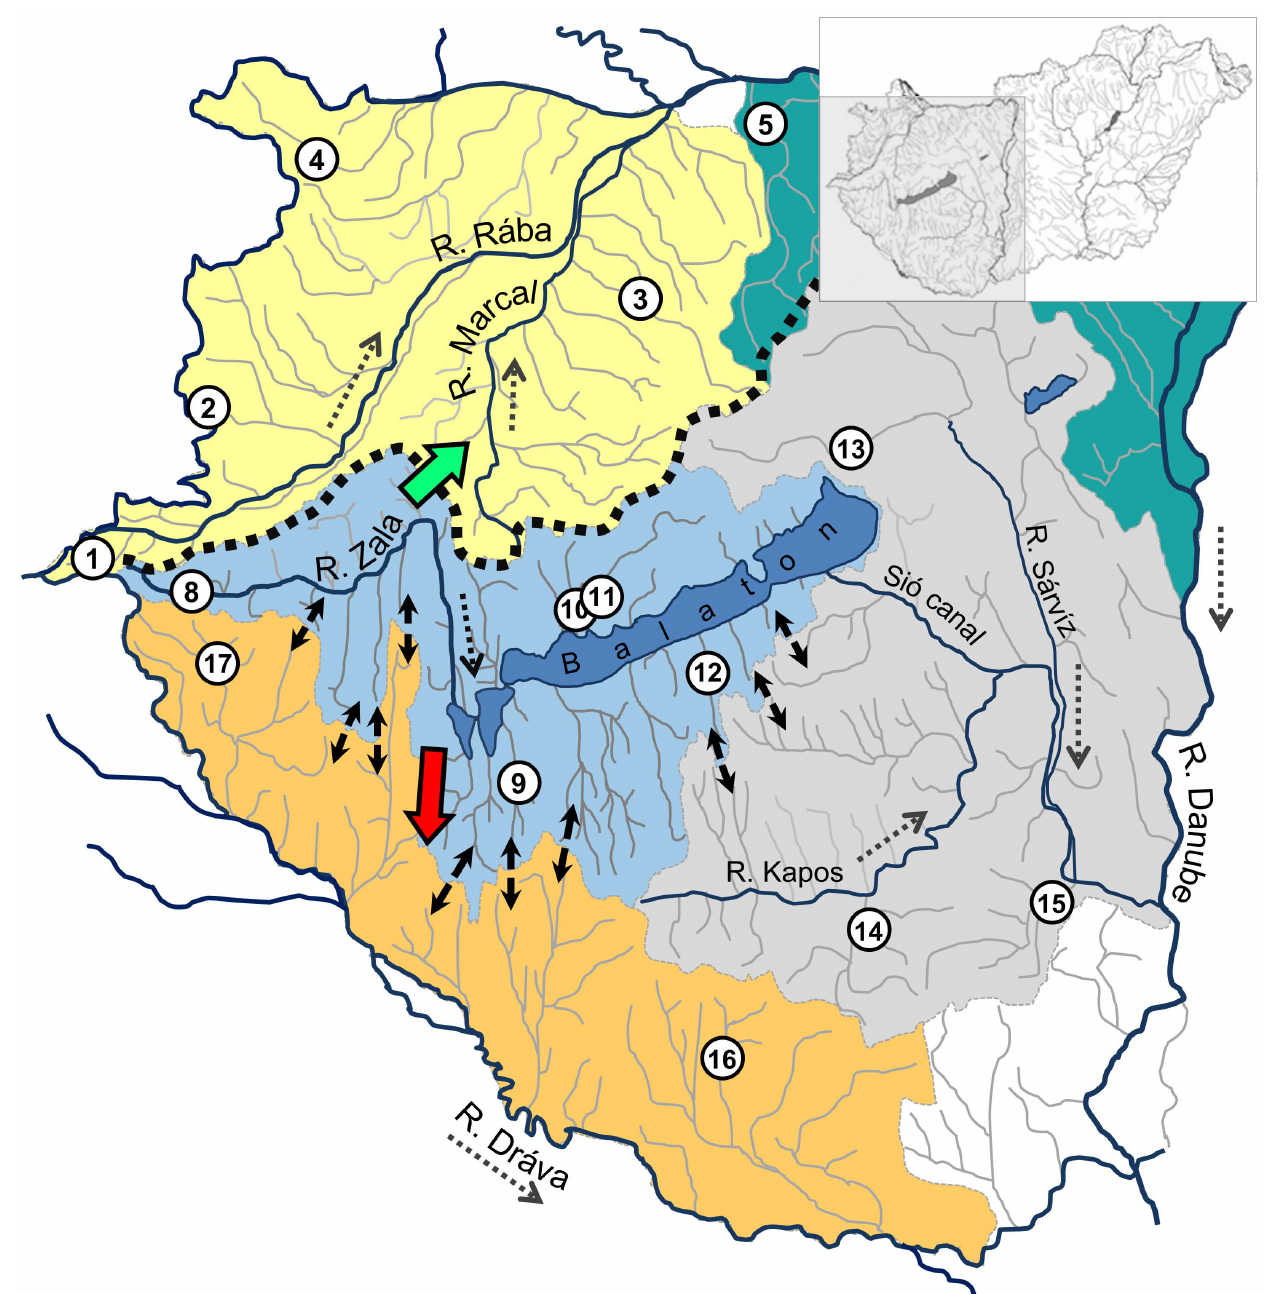
Figure 6. Recent river network of the Danubian region (Hungary). The four subcatchment areas are indicated by different colours. Flow direction of Zala River during the Middle and Late Pleistocene is indicated by blackframed green and red arrows respectively. The thick broken line indicates the Pleistocene watershed between the North and Middle Danubian regions. Intra-valley drainage divides (Sı´khegyi, 2002) are shown by black bidirectional arrows. Numbered circles: sampling sites displayed in Table 1. Dotted arrows: recent flow direction. Middle and South Danubian regions were the richest in under Accession Nos. KC757328-42. The sequences of the CR03 haplotypes. Moreover nine out of the 10 haplotypes found were and CR14 haplotypes had already been identified from the unique to these regions (Table 3). Results of the median-joining Danube catchment in the Czech Republic and in Slovakia [33], Network analysis showed that haplotypes described from Hungary and were demonstrated by megaBLAST [66] to be Gobio gobio were classified into five haplogroups (A, B, C, D, F ‘boxes’ in (100% similarity with the specimen: EU131542) and G. carpathicus Fig. 2). Through the AMOVA analysis, 85% of the total genetic (100% similarity with the specimen: EU131559) respectively. variance was explained by among haplogroup differences, and in From the North Danubian region only three and from the Tisza addition significant (p , 0.001) differentiation was found in each River catchment a total of five haplotypes were displayed. The